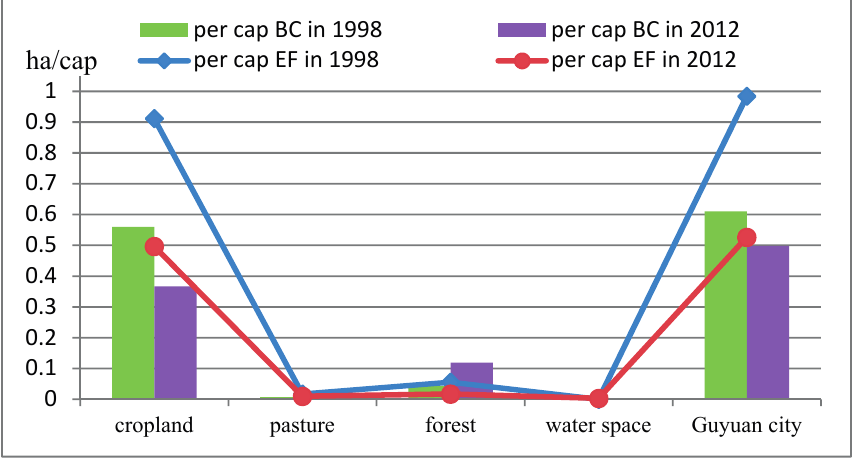
Figure 4. The EF and BC before and after the Green for Grain Project (1998 and